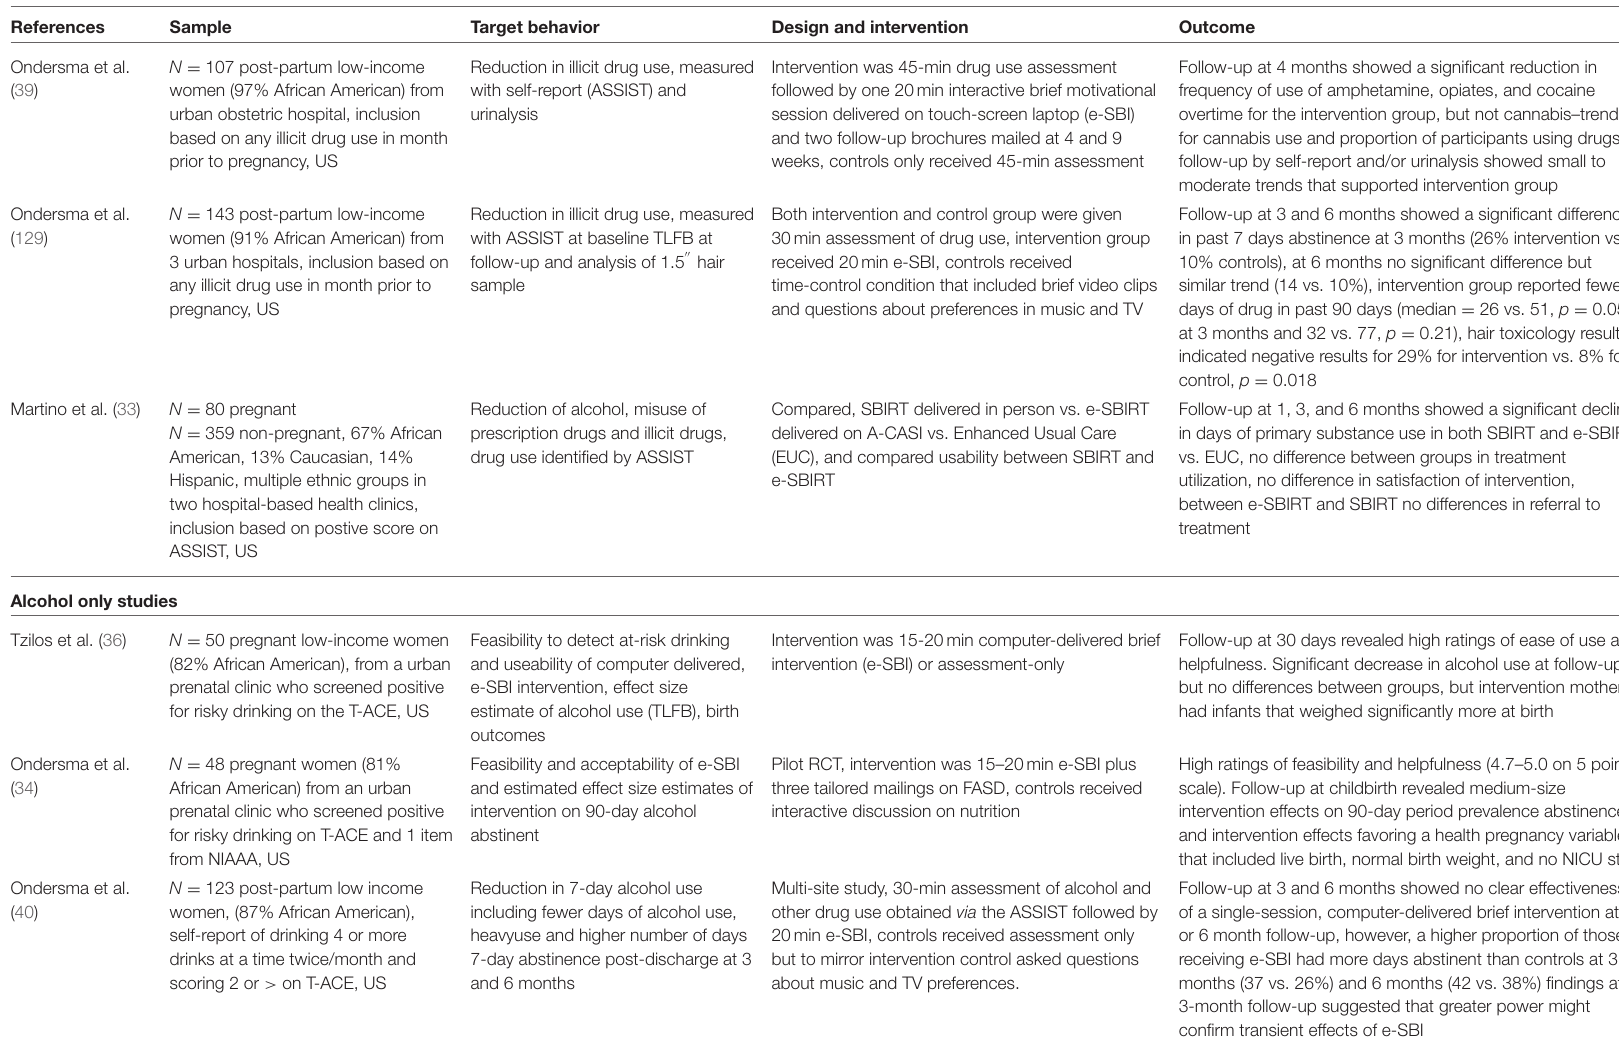
TABLE 2 | Evidence of selected RCTs investigating technology delivered brief motivational interventions, SBIRT and e-SBIRT or